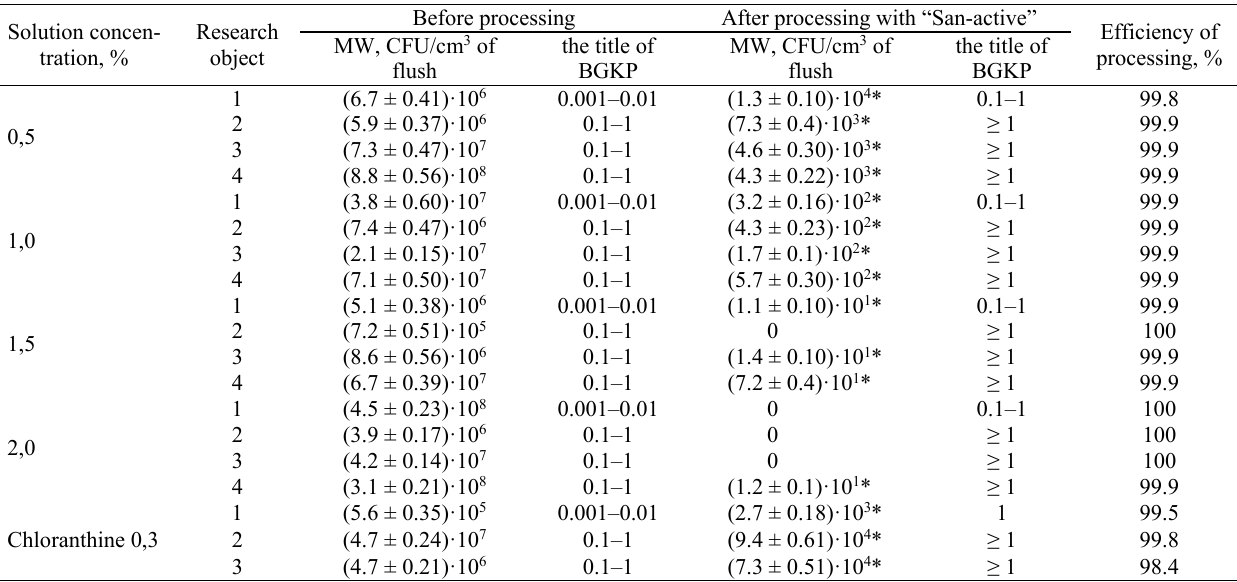
Microbiological indicators of washings out of technological equipment in the intestinal workshop using the